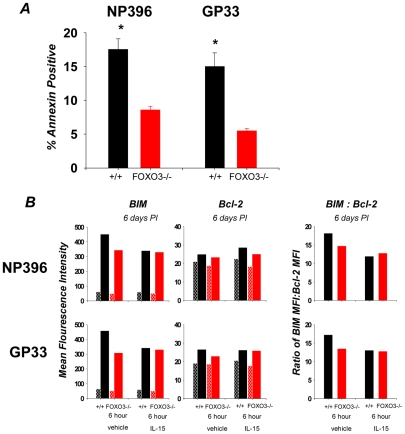
Activated CD8 T cells in FOXO3−/− mice display decreased apoptosis.To address whether the increase in antigen-specific cells observed in FOXO3−/− mice at day 8 was in fact the result of decreased apoptosis, we assessed the relative expression levels of a number of cell survival or cell death markers. (A) Splenocytes isolated from day 6 PI mice were stained with anti-CD8, MHC-I tetramers and Annexin V directly ex vivo. Data is expressed as percentage of Annexin V positive cells amongst tetramer-binding CD8 T cells. Data are from at least two independent experiments with 4 mice/group/experiment; error bars represent the SEM and * indicates statistical significance at p<.005 (B) At day 6 PI, splenocytes from +/+ and FOXO3−/− mice were cultured for 6 hours with or without IL-15. After culture, cells were stained with MHC I tetramers, anti-CD8, anti-BIM, and anti-Bcl-2. The MFI of staining for BIM and Bcl-2 in tetramer-binding CD8 T cells was assessed by flow cytometry (left and middle); adjacent checkered bars are the MFIs with isotype control antibodies. In B, bar graphs on the right show the ratios of BIM:Bcl-2 MFI.